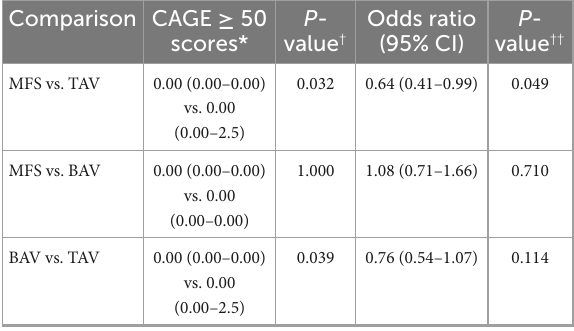
TABLE 3 Comparisons of obstructive coronary sclerosis. Comparison CAGE ≥